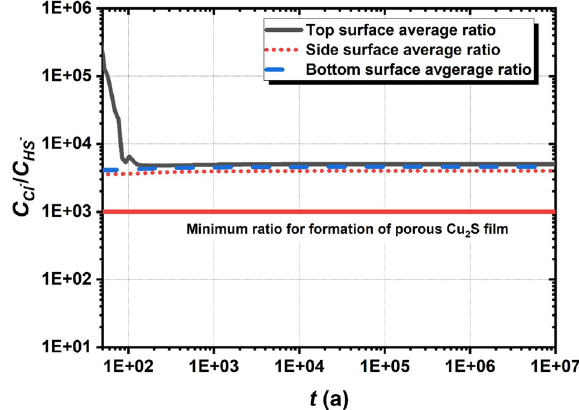
Fig. 15 Ion ratio change with time evolution. Cl − and HS − concentration ratios (C Cl − /C HS − ) for Cu canister top, side, and bottom surfaces plotted as functions of time 61